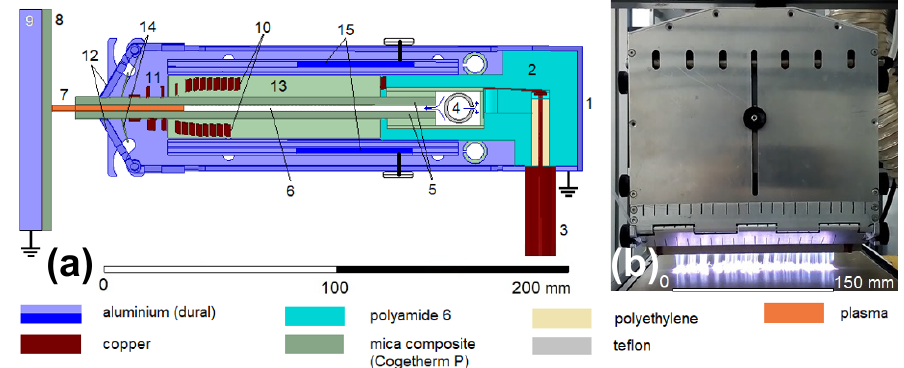
Figure 1. ( a ) Schematic drawing of the RF plasma slit jet (side view): 1—aluminum cover/shielding; 2—load-bearing element; 3—coaxial cable; 4—Ar flow homogenization region; 5—mica composite slit body; 6—slit; 7—plasma region; 8—sample; 9—grounded metal desk; 10—resonance coil; 11— high-voltage radio-frequency electrodes; 12—system of movable grounded electrodes; 13—dielectric plates of an electrical breakdown limiter; 14—plates supporting the coil turns; 15—conductive plates